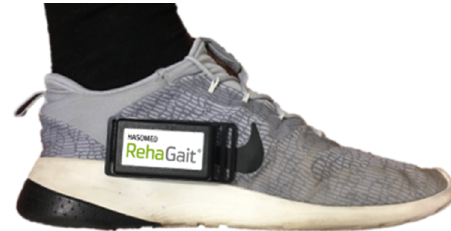
Figure 13. Sensor position: inside of the foot .